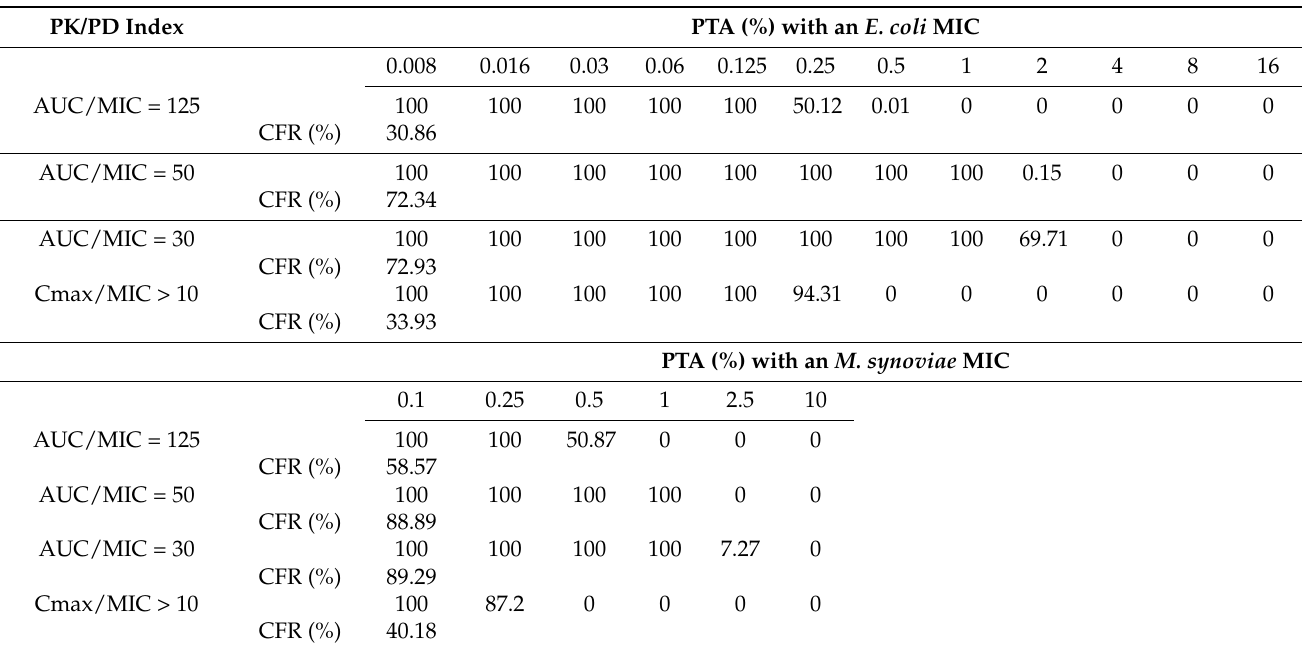
Table 2. Monte Carlo simulation ( n = 10000 subjects) of target attainment for a simulated black vulture population after intramuscular administration of enrofloxacin at 10 mg/kg for MIC distribution of E. coli and M. synoviae previously published